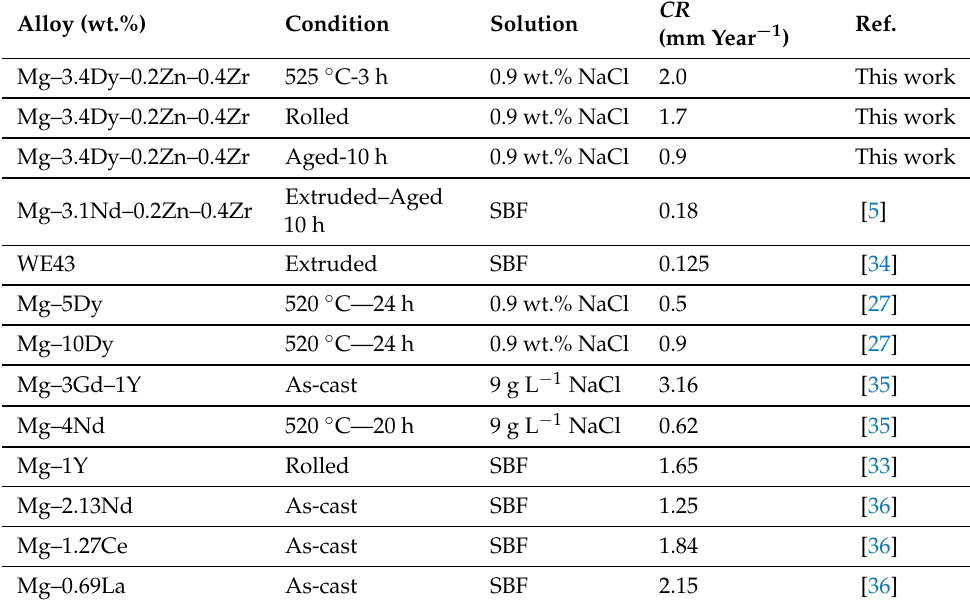
Table 2. Comparison of corrosion rate of H525 ◦ C-3 h, rolled and aged-10 h specimens with data from the